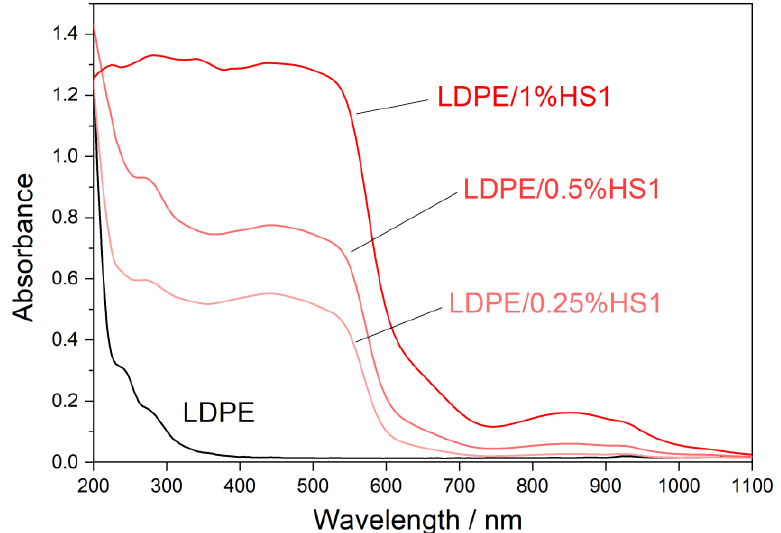
Figure 8. Absorbance UV-Vis-NIR spectra (obtained from diffuse reflectance) of LDPE and LDPE/HE1 composites.